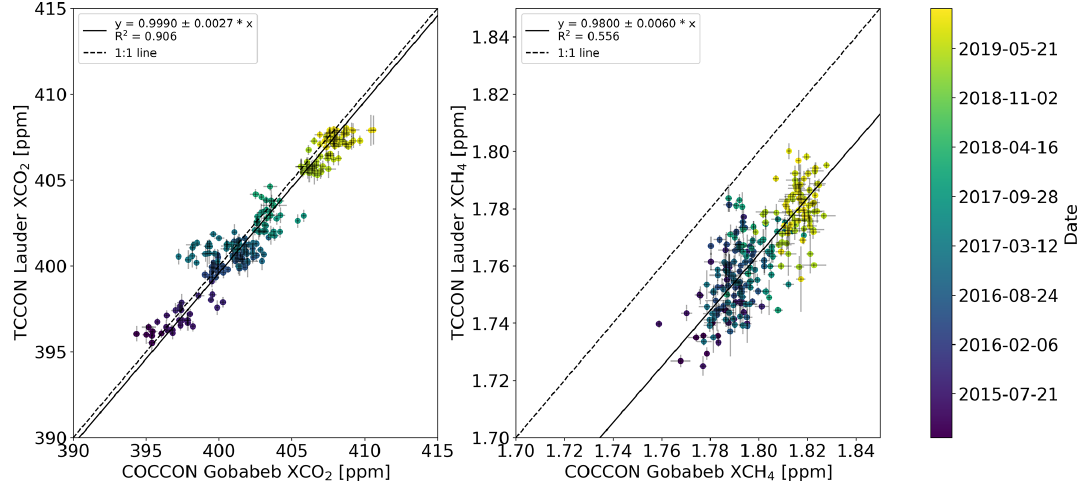
Figure 8. Correlation plots between the COCCON Gobabeb and TCCON Lauder stations for XCO 2 and XCH 4 from 2015 to 2019. Shown are daily mean values; error bars denote the 1 σ standard deviation. The color bar denotes the date of the measurement.